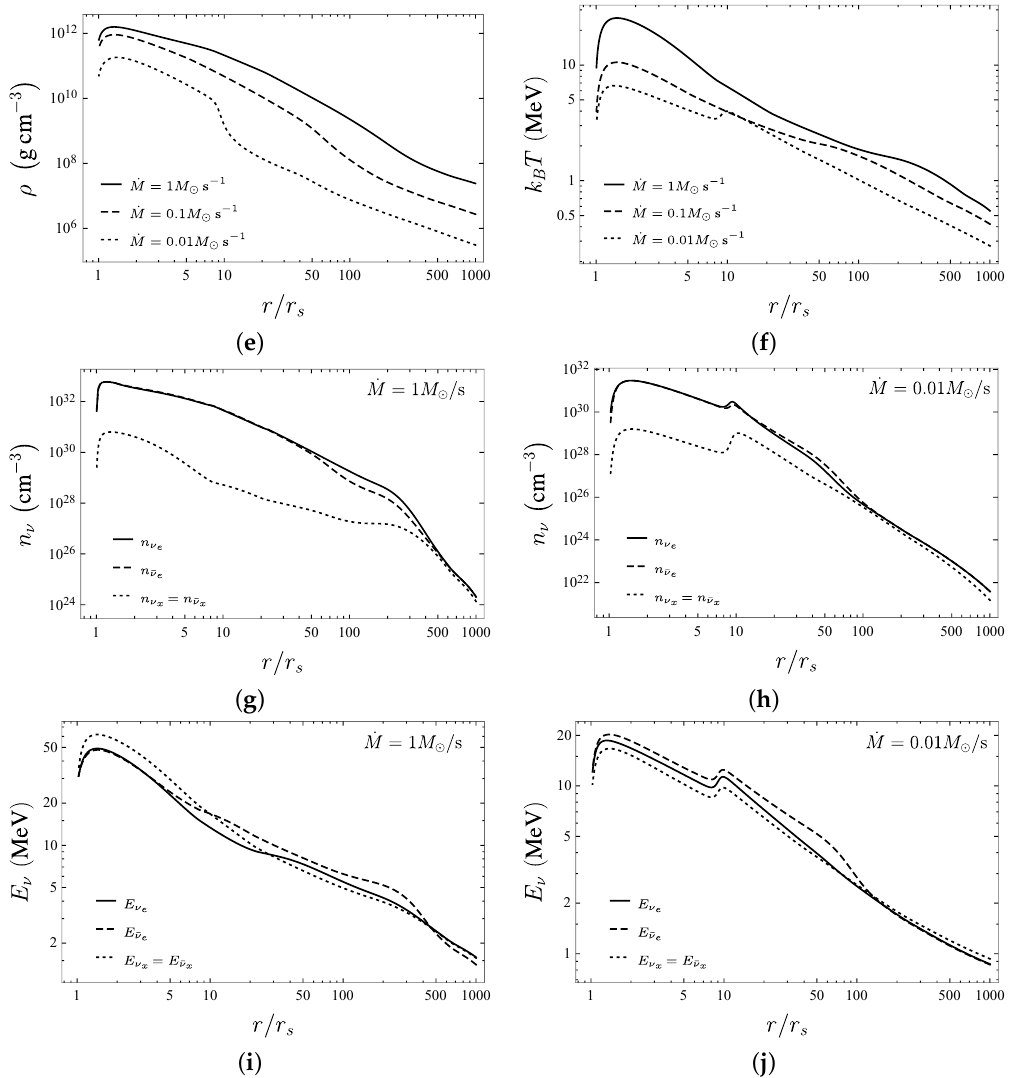
Figure 3. Properties of accretion disks in the absence of oscillations with M = 3 M (cid:12) , α = 0.01, a = 0.95. ( a , b ) The mass fraction inside the disk. We have plotted only the ones that appreciably change. ( c ) The electron degeneracy parameter. ( d ) The comparison between the neutrino cooling flux F ν and the viscous heating F heat . ( e ) The baryon density. ( f ) The temperature. ( g , h ) The neutrino number density. ( i , j ) The average neutrino